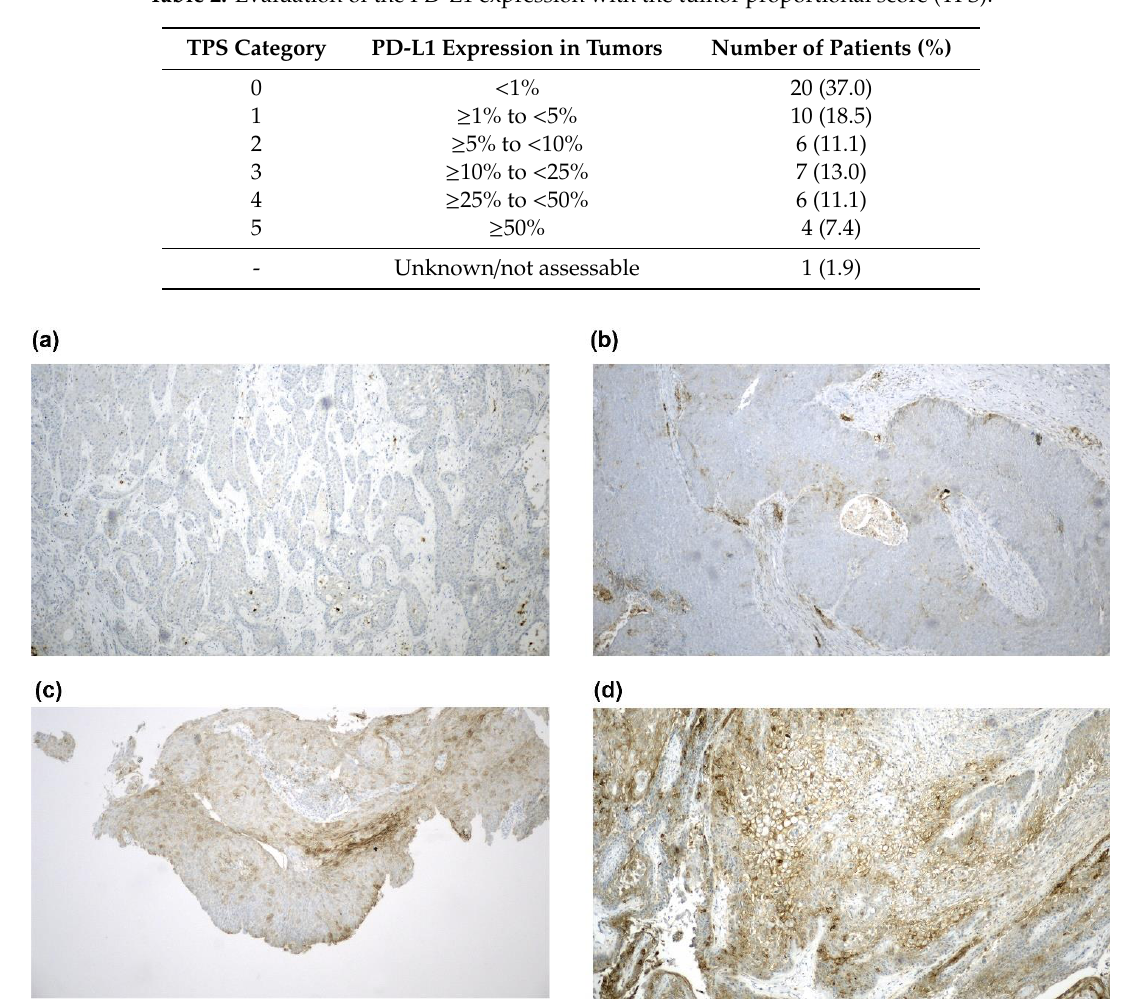
Figure 3. PD-L1 staining. Representative images of tumor samples categorized as ( a ) TPS category 0 (PD-L1 negative), ( b ) TPS category 1, ( c ) TPS category 3, and ( d ) TPS category 5. 100× magnification.